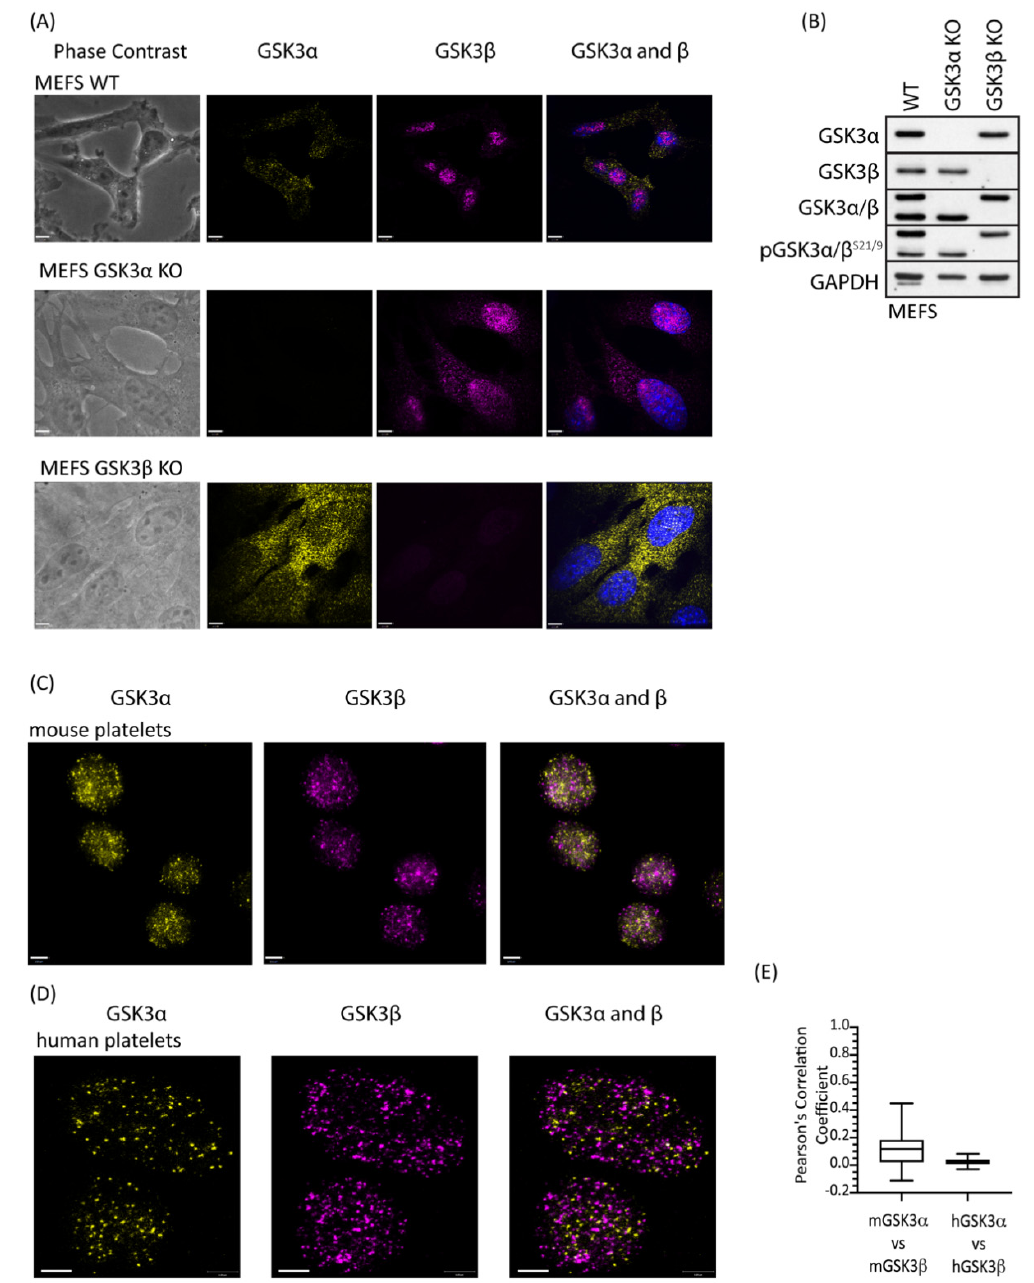
Figure 2. GSK3 paralogs localise to distinct locations in mouse and human platelets. Platelets and MEFs were stained with antibodies specific for GSK3 α (D80D1, #4818 CST) and GSK3 β (MRU PPU) and imaged using a Leica TCS SP8 STED system: ( A ) Representative images of WT, GSK3 α KO and GSK3 β KO MEFs stained with antibodies against GSK3 α (yellow) and GSK3 β (magenta) in the presence of 4 ′ ,6-diamidino-2-phenylindole (DAPI, blue) indicated that antibodies used for localisation analyses are specific for GSK3 α and GSK3 β . Bar represents 6 µm. ( B ) Immunoblotting of WT, GSK3 α KO, and GSK3 β KO MEFs for GSK3 α , GSK3 β , and pGSK3 α / β S21/9 verifies that MEFs have either GSK3 α or GSK3 β deleted. Data are representative of 3 independent experiments. ( C ) Representative images of mouse platelets showing GSK3 α (yellow) and GSK3 β (magenta). Bar represents 1 µm. ( D ) Representative images of human platelets showing GSK3 α (yellow) and GSK3 β (magenta). Bar represents 1 µm. ( E ) Pearson’s correlation coefficient analysis demonstrates that GSK3 α and GSK3 β are unlikely to interact physically in mouse (mGSK3 α vs. mGSK3 β , 62 images) and human (hGSK3 α vs. hGSK3 β , 22 images) platelets.